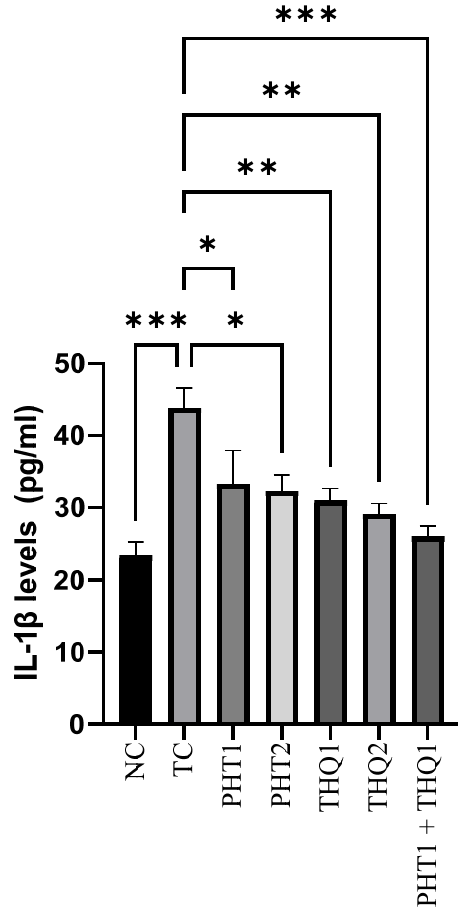
Figure 4. Effect of PHT (20 and 40 mg/kg), THQ (40 and 80 mg/kg) and PHT (20 mg/kg) + THQ (40 mg/kg) on hippocampal IL -1 β levels following MES-induced convulsions in rats. One-way ANOVA followed by Dunnet’s test was used to compare quantitative variables from the toxic control vs. other groups. PHT, THQ, TC and MES indicate phenytoin, thymoquinone, toxic control and maximal electric shock, respectively. * p < 0.05, ** p < 0.01, *** p < 0.001